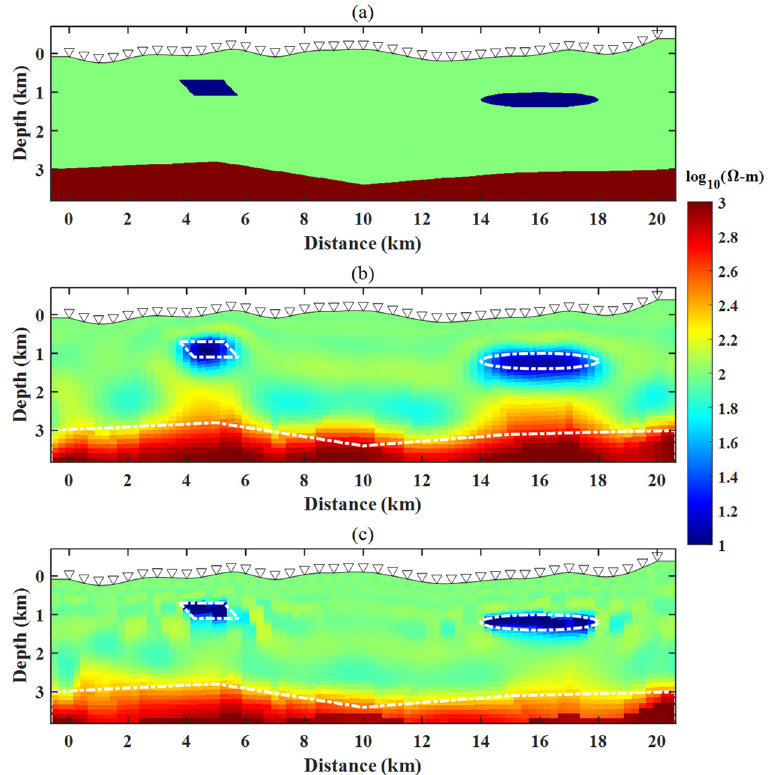
Figure 2. Inversion model and results: ( a ) the model, ( b ) the inversion result of the conventional inversion method, and ( c ) the inversion result of the multiplier method.